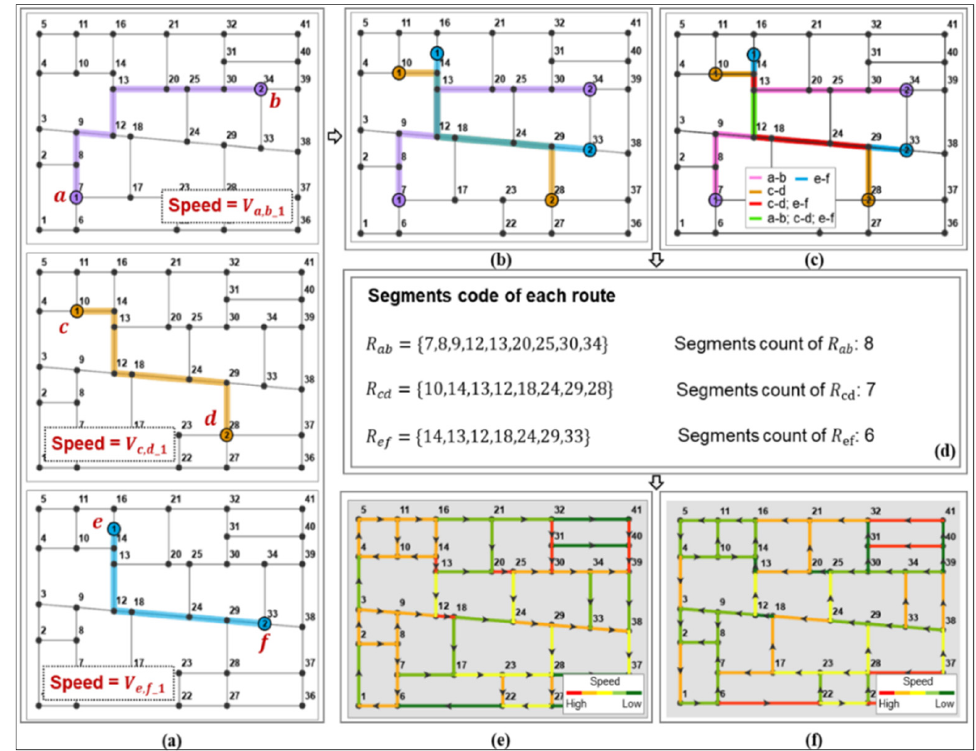
Figure 4. Rhythm analysis method based on the cycling paths of public bicycles. ( a ) three cycling paths of public bicycles trips; ( b ) the overlap of three cycling paths on roads; ( c ) decomposition of cycling paths on road segments; ( d ) segments code of each route; ( e ) the high- to low-speed distribution of cycling on road segments; ( f ) the low- to high-speed distribution of cycling on road segments.